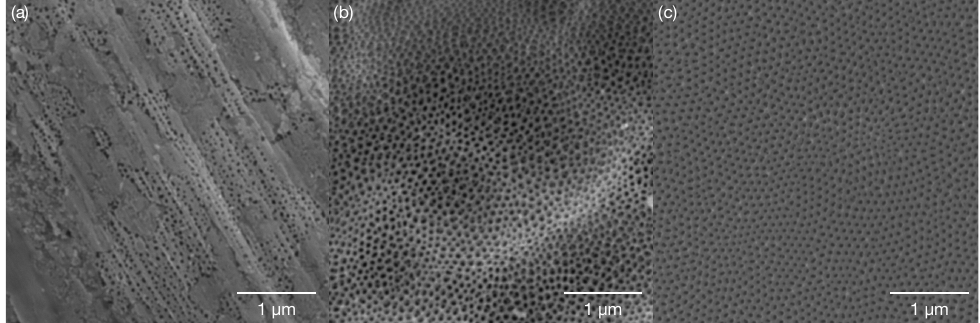
Figure 2. Scanning electron micrographs of the anodised membranes: ( a ) AAO Clean , ( b ) AAO Cl and ( c ) AAO Cl+Cr . Table 2. The pore size and average distance between them for the anodised membranes. Sample Pore Size [nm] Distance between Pores [nm]